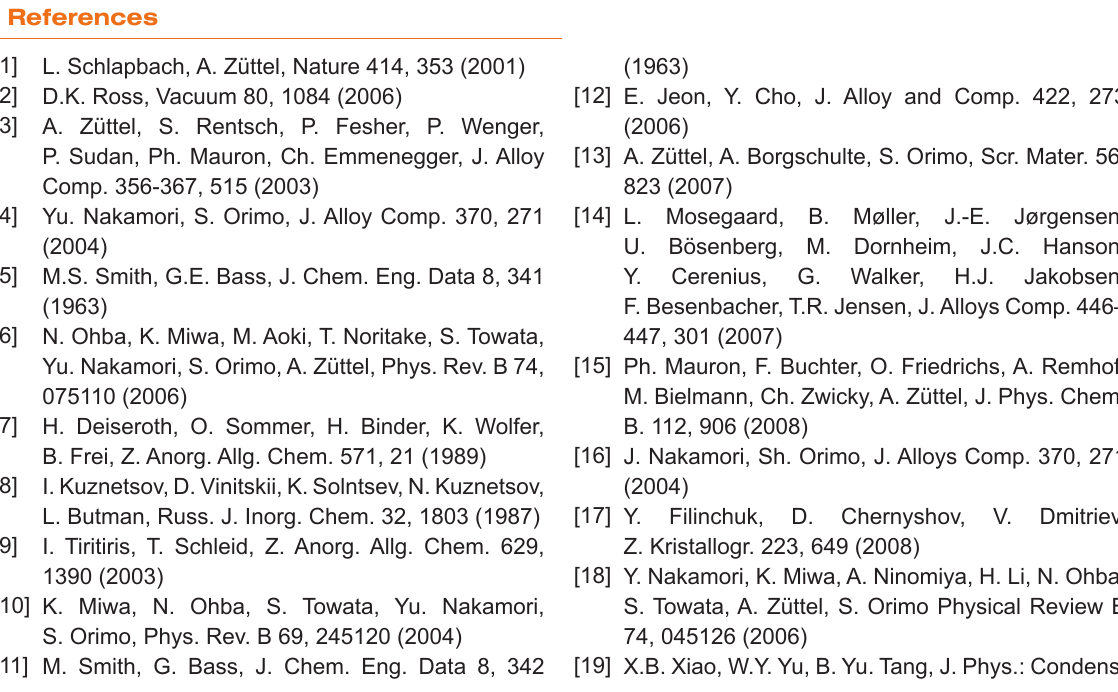
in a 2:1 molar ratio. 2 , 2